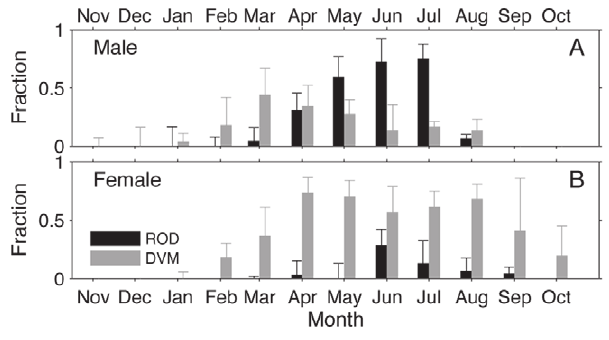
Figure 7. The fraction of time each month that male (A) and female (B) white sharks engaged in ‘ROD’ (black) and ‘DVM’ (grey) behavior. The bars represent median values, while the error bars show the upper inter-quartile range among individuals.